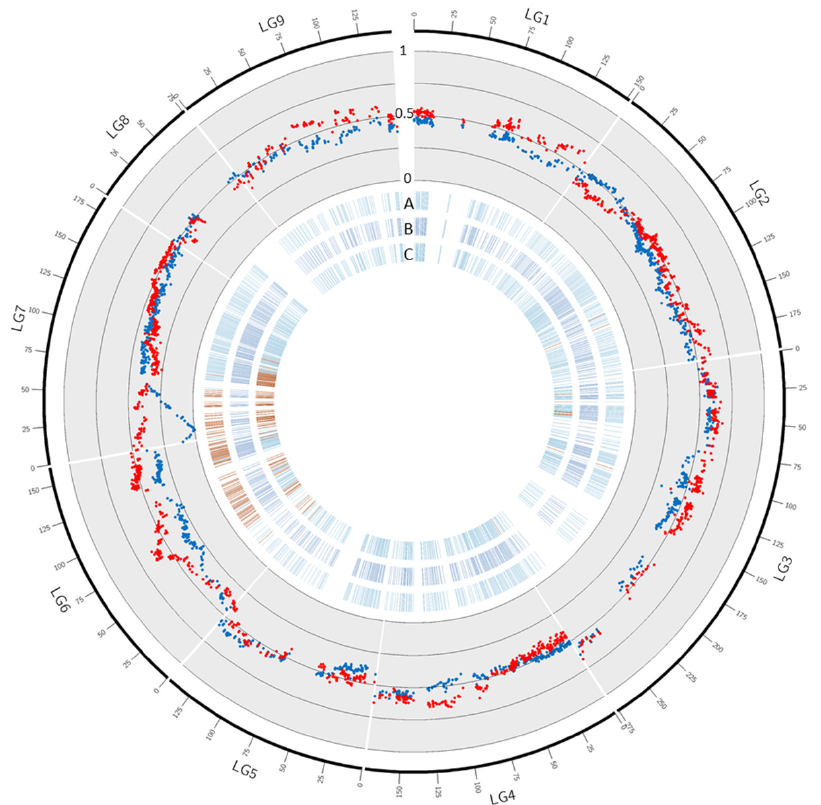
Figure 3. Segregation distortion in ‘Fortune’. The blue and red dots in the scatter plot represent respectively, male, and female gamete frequency in ‘Fortune’ haplotype 1. A, B, and C: blue and red dashes: markers with non-significant and significant distortion in ( A ): male gametes, ( B ): female gametes and ( C ): all gametes. Table 3. Number of markers with significant segregation distortions for all efficient male and female gametes of ‘Fortune’ mandarin and ‘Ellendale’